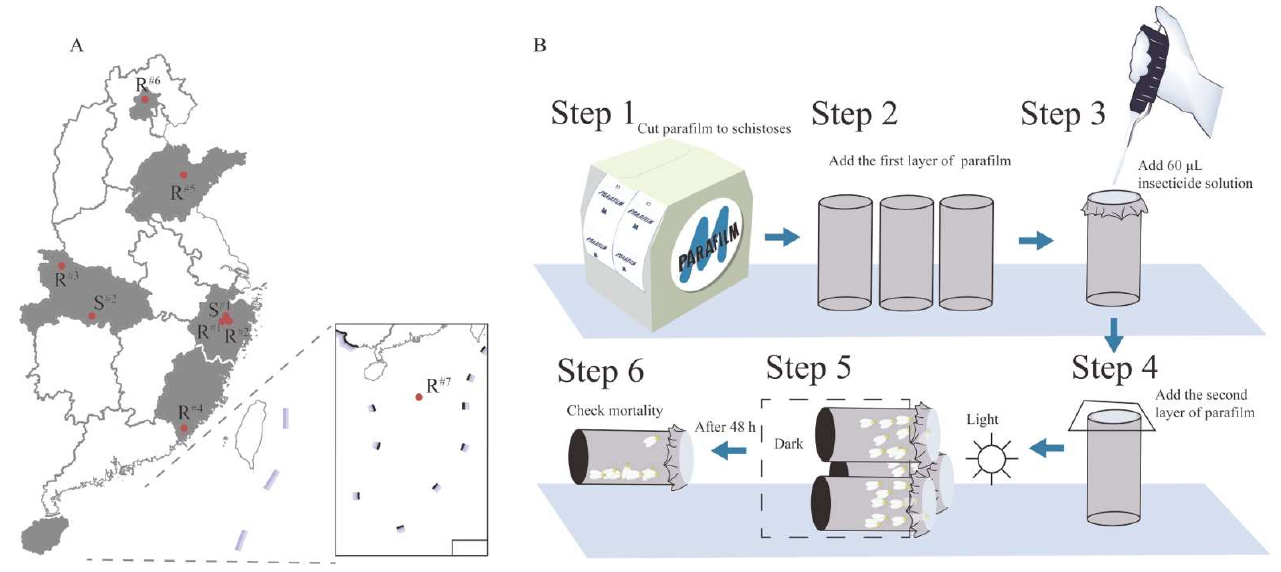
Figure 1. Map of China showing the provinces (shaded gray) where field populations of B. tabaci were collected ( A ) and a diagram of the feeding method used in the insecticide bioassay for B. tabaci ( B ). S: susceptible strain; R: resistant strain. The red shading indicates the specific collection loca-